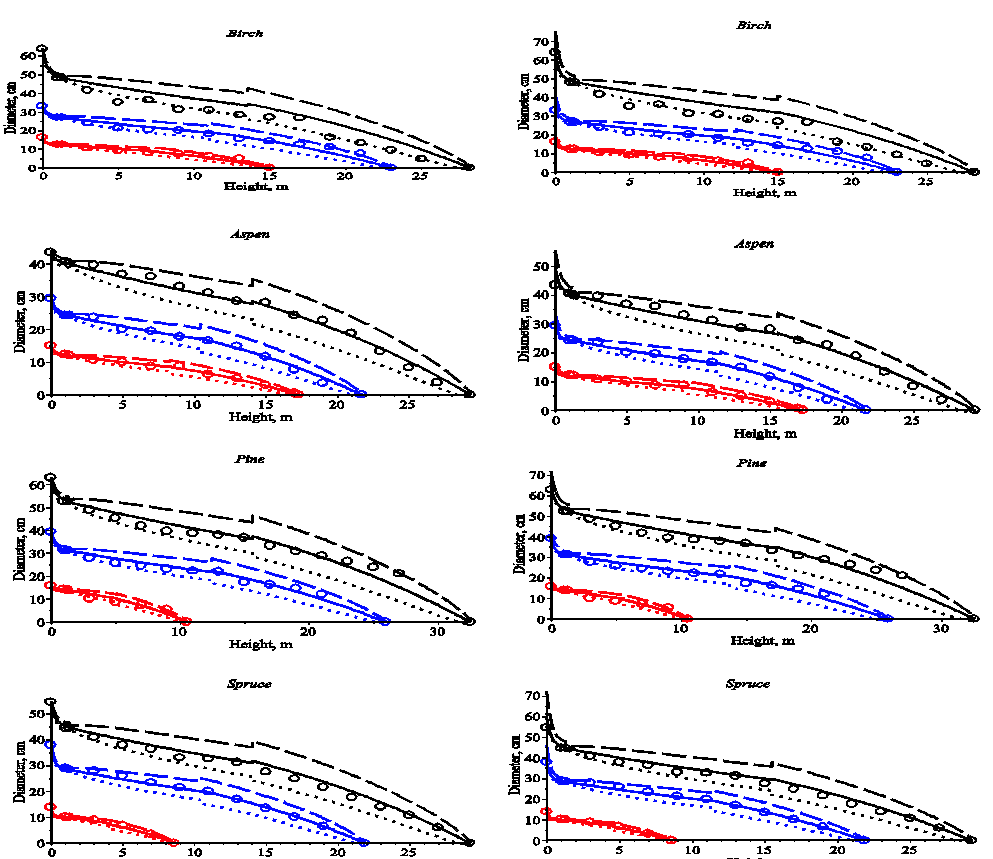
Figure 2. Evolution of the mean and p -quantile for stem diameter. Left shows Model 1, right shows Model 3. The large tree is denoted in black, the medium tree in blue, and the small tree in red. The mean trajectory is denoted with the solid line, the 0.025-quantile trajectory is denoted with the dotted line, and the 0.975-quantile trajectory is denoted with the dashed line.